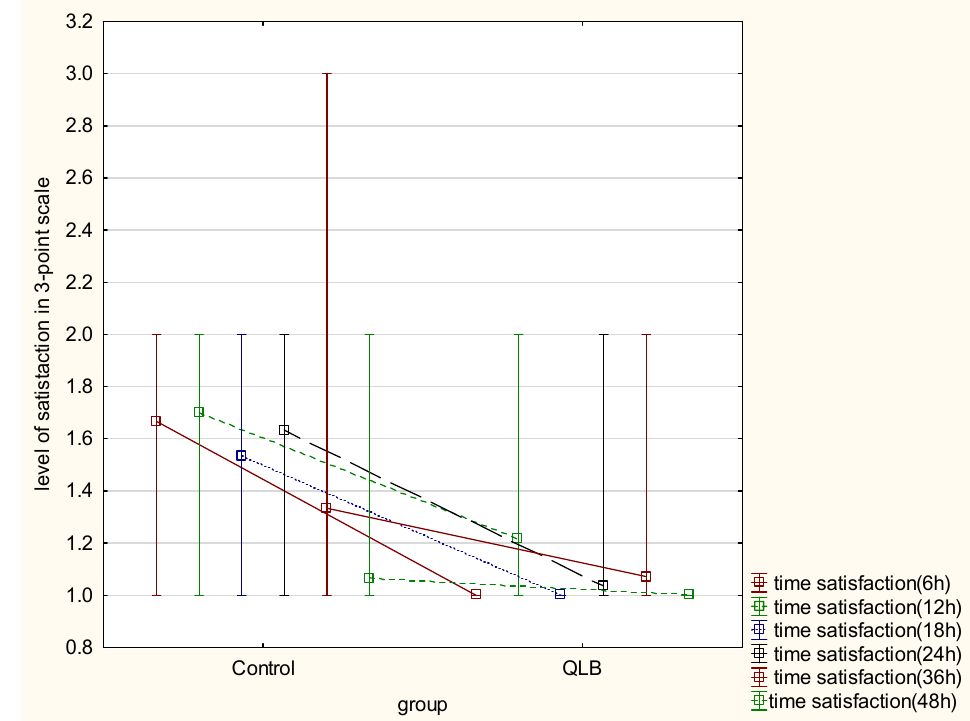
Figure 2. Level of satisfaction with pain therapy in 3-point scale. Presented as figure of interactive mean and interquartile ranges between control group and QLB group, comparing time and level of satisfaction using Greenhouse–Geisser test ( p = 0.000).